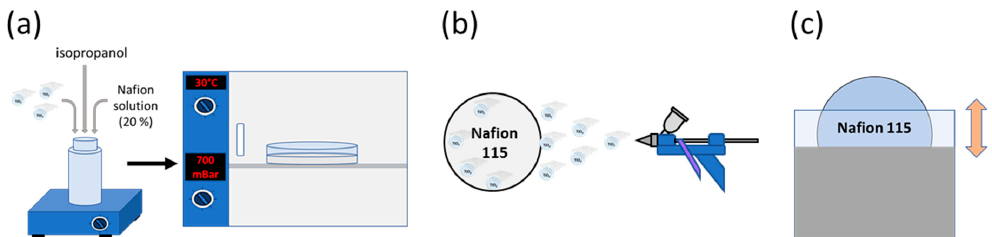
Figure 1. Photocatalytic immobilization methods: solvent-casting (SC) ( a ), spraying (SP) ( b ) and dip- coating (DP) ( c ).